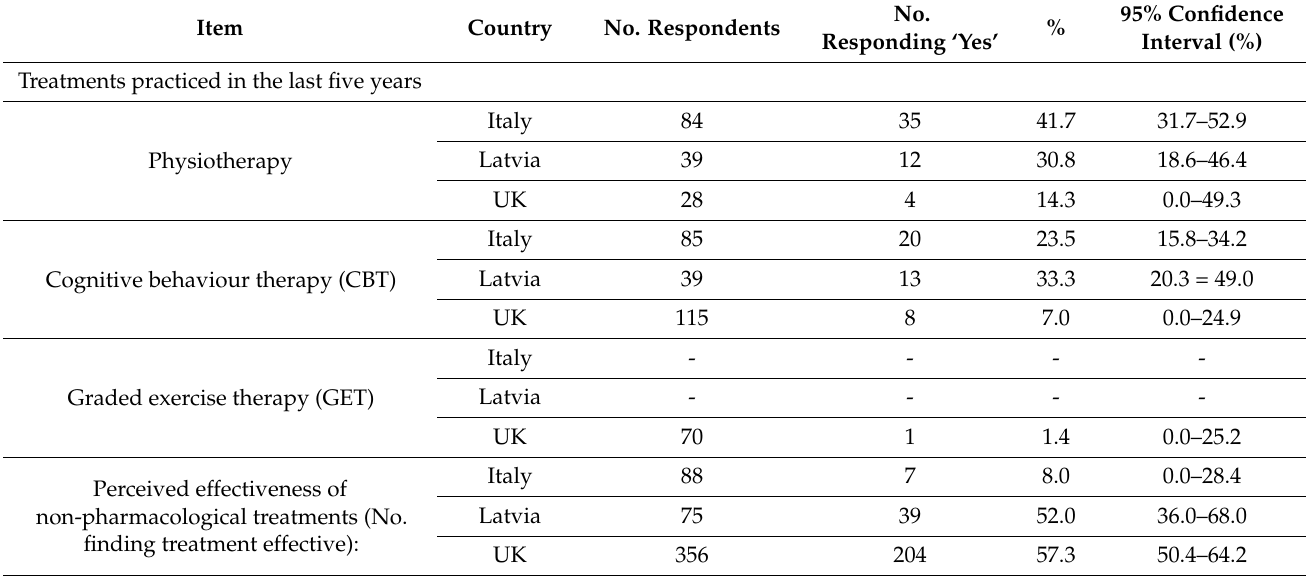
Table 4. Perceived effectiveness of treatment.